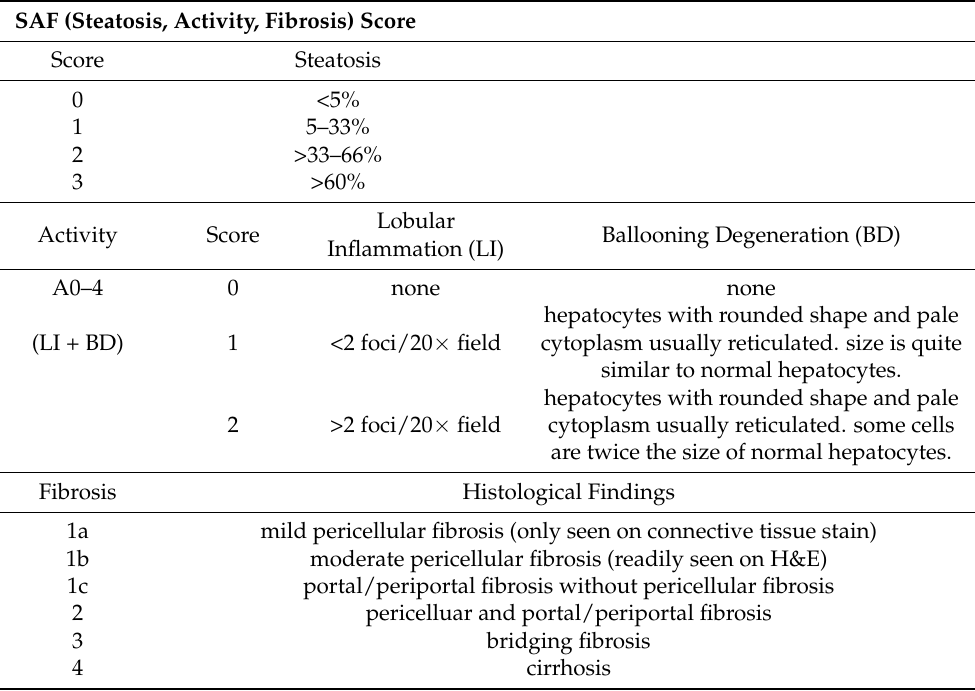
Table 2. Steatosis, Activity, and Fibrosis (SAF) score. Adapted from [35]. SAF (Steatosis, Activity, Fibrosis)